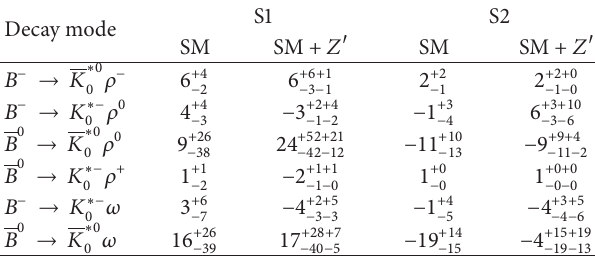
Table5:Thedirect 𝐶𝑃 asymmetry(%)underthedifferentscenarios. S1 Decay mode